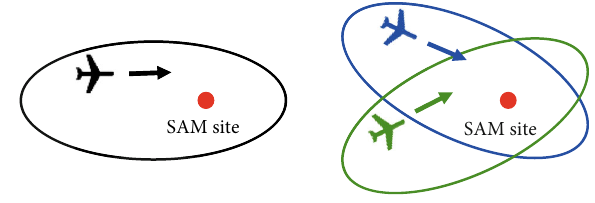
Figure 3: Dynamic SAM lethal envelope.